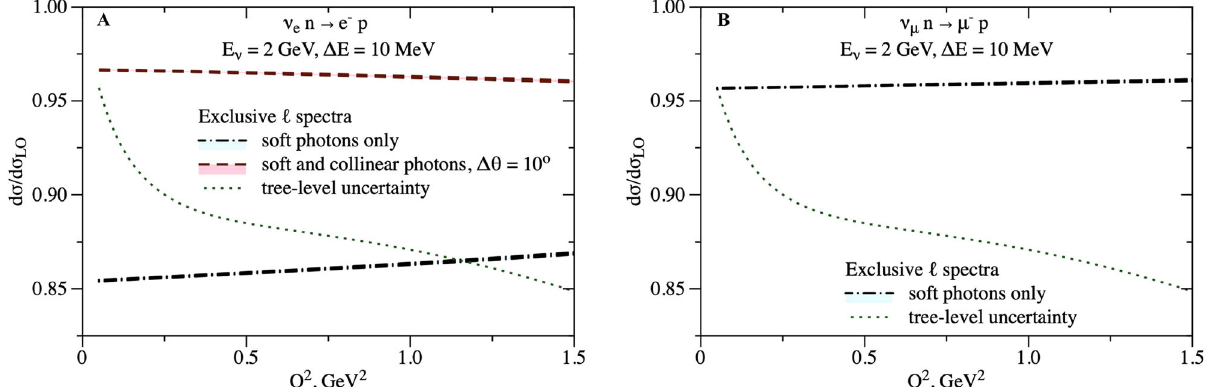
Fig. 3 | Radiatively corrected cross-section ratio to the tree-level result and corresponding uncertainty in neutrino scattering for exclusive observables. ThelegendcorrespondstothepanelsAandCinFig.2.Thetree-levelcross-section